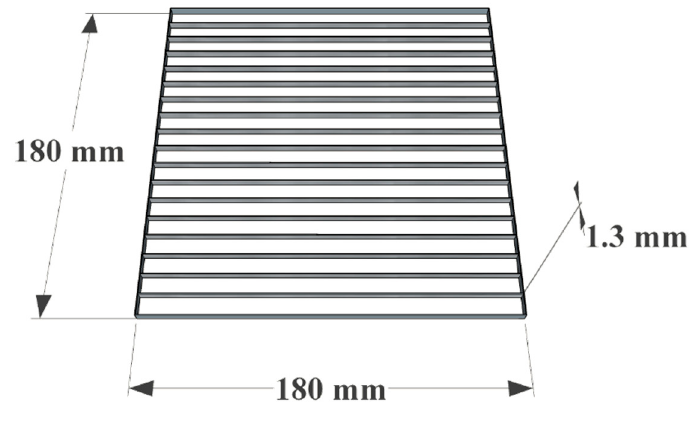
Figure 9. Plant grid used for the TLC bioautography assays.